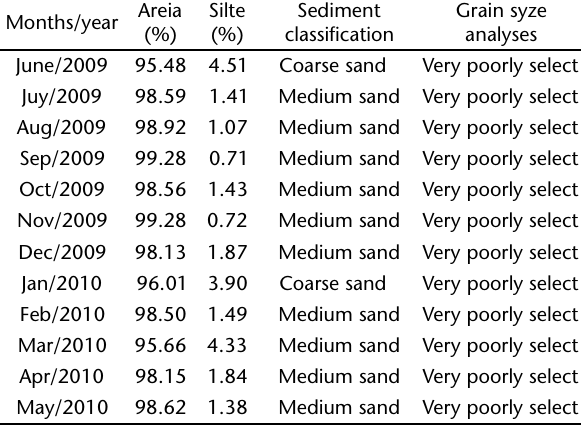
Table II. Sediments parameters from the Manguinhos beach, between June 2009 and May